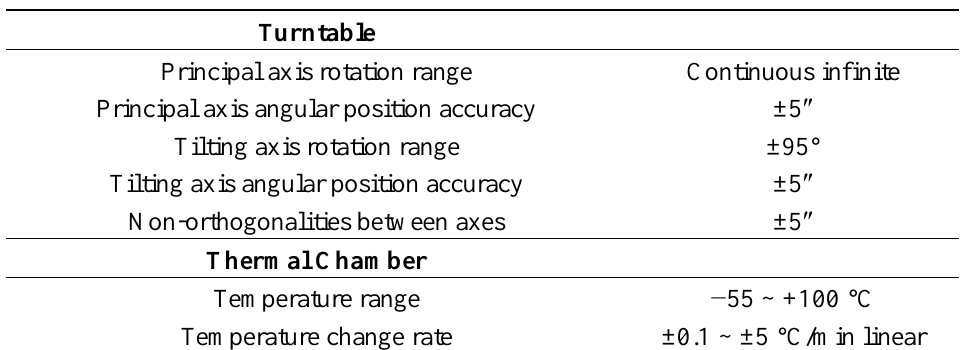
Table 1. Performance of thermal calibration